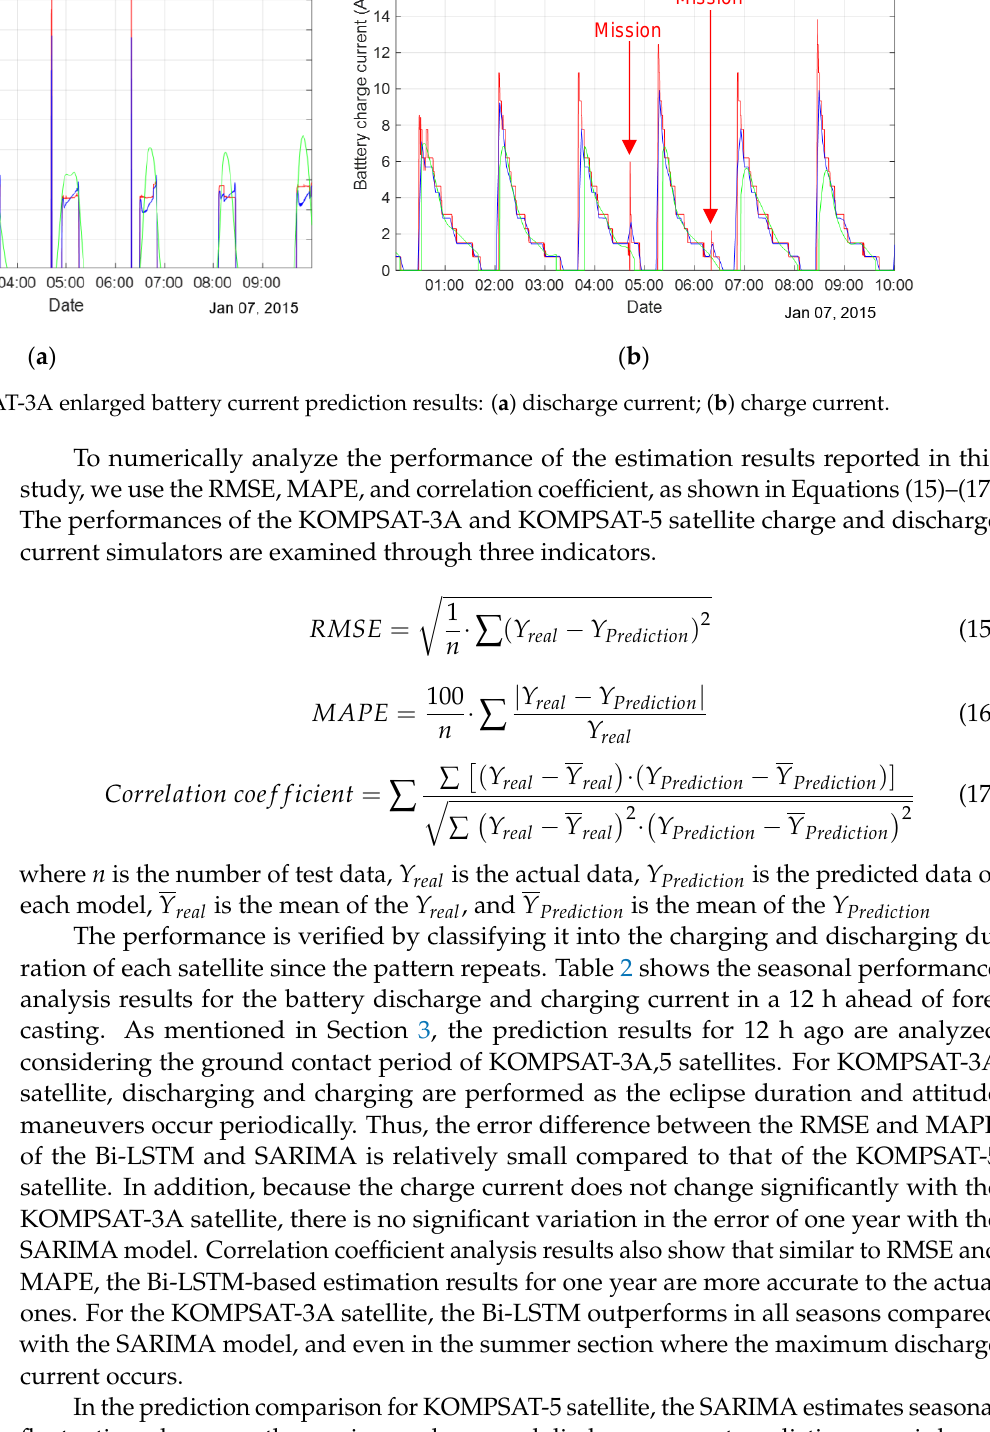
Figure 10. KOMPSAT-5 battery charge and discharge current prediction results: ( a ) SARIMA results for discharge current; ( b ) SARIMA results for charge current; ( c ) Bi-LSTM results for discharge current; ( d ) Bi-LSTM results for charge current.